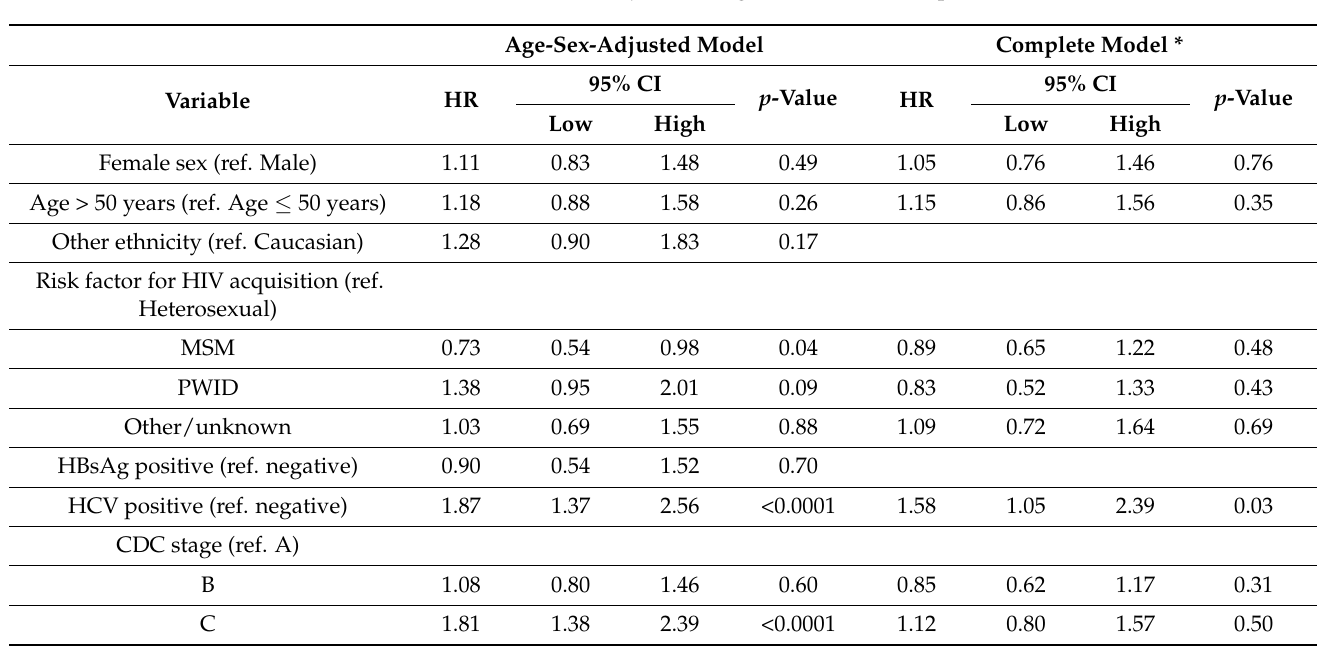
Table 6. Hazard ratios (HR) and 95% confidence interval (95% CI) for any cause treatment interruption in 749 antiretroviral naive subjects during the entire